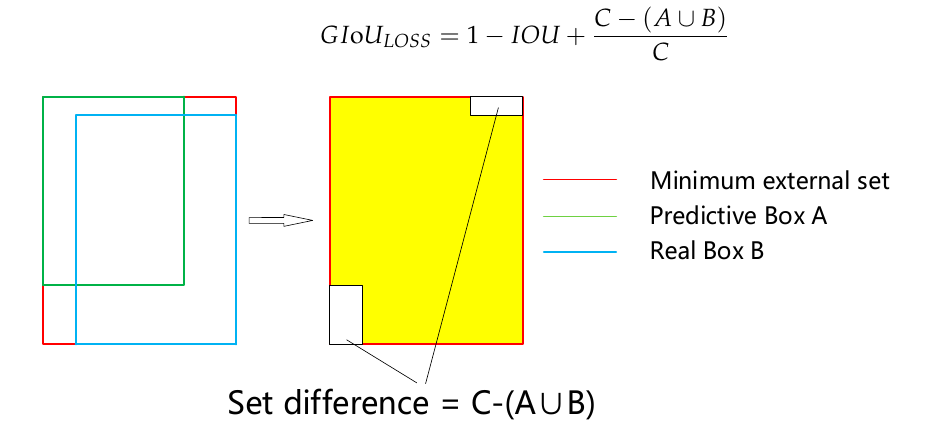
Figure 7. Schematic diagram of GIoU_Loss loss function.